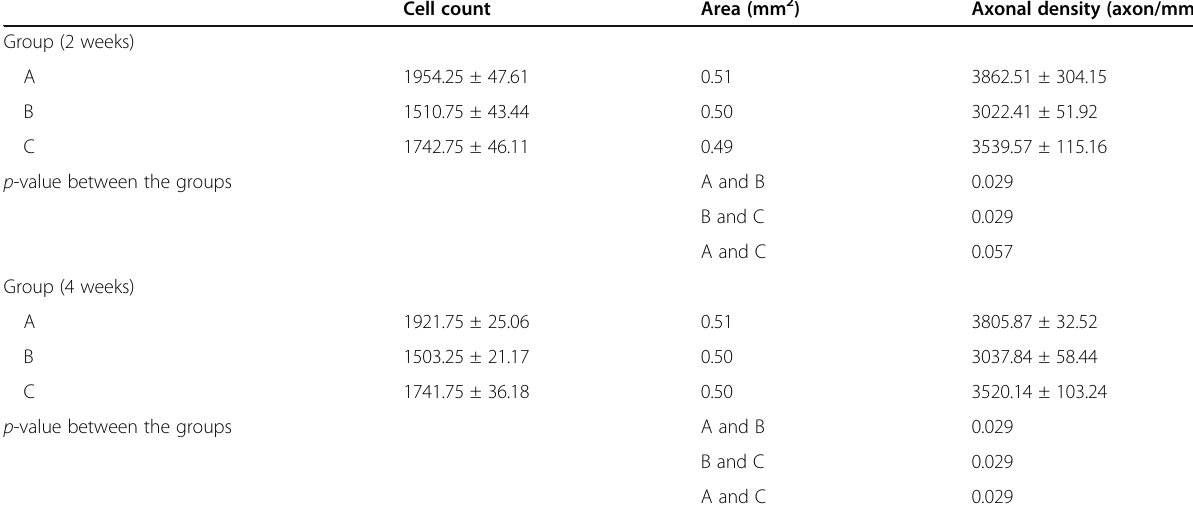
Table 4 Total number of axons and axonal density Cell count Area (mm 2